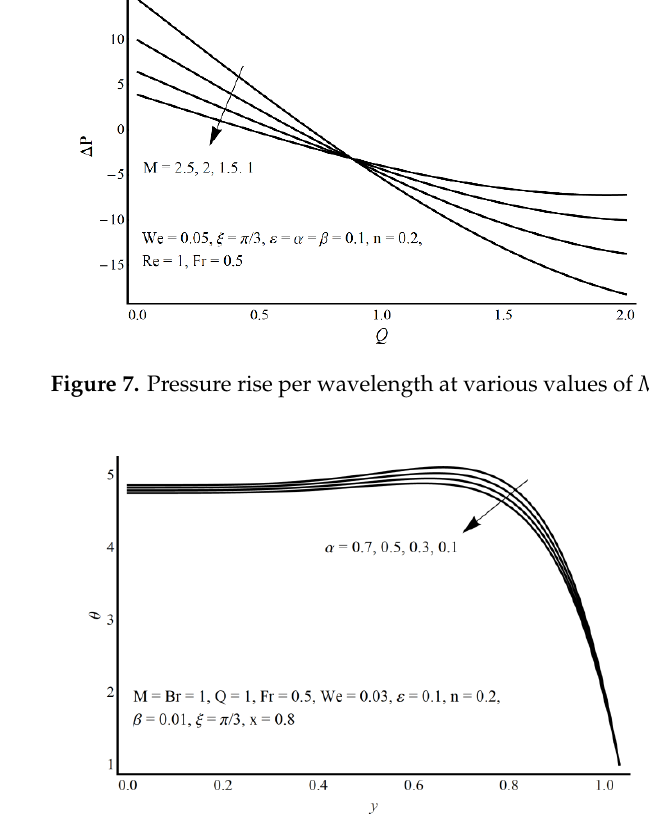
Figure 7. Pressure rise per wavelength at various values of M.